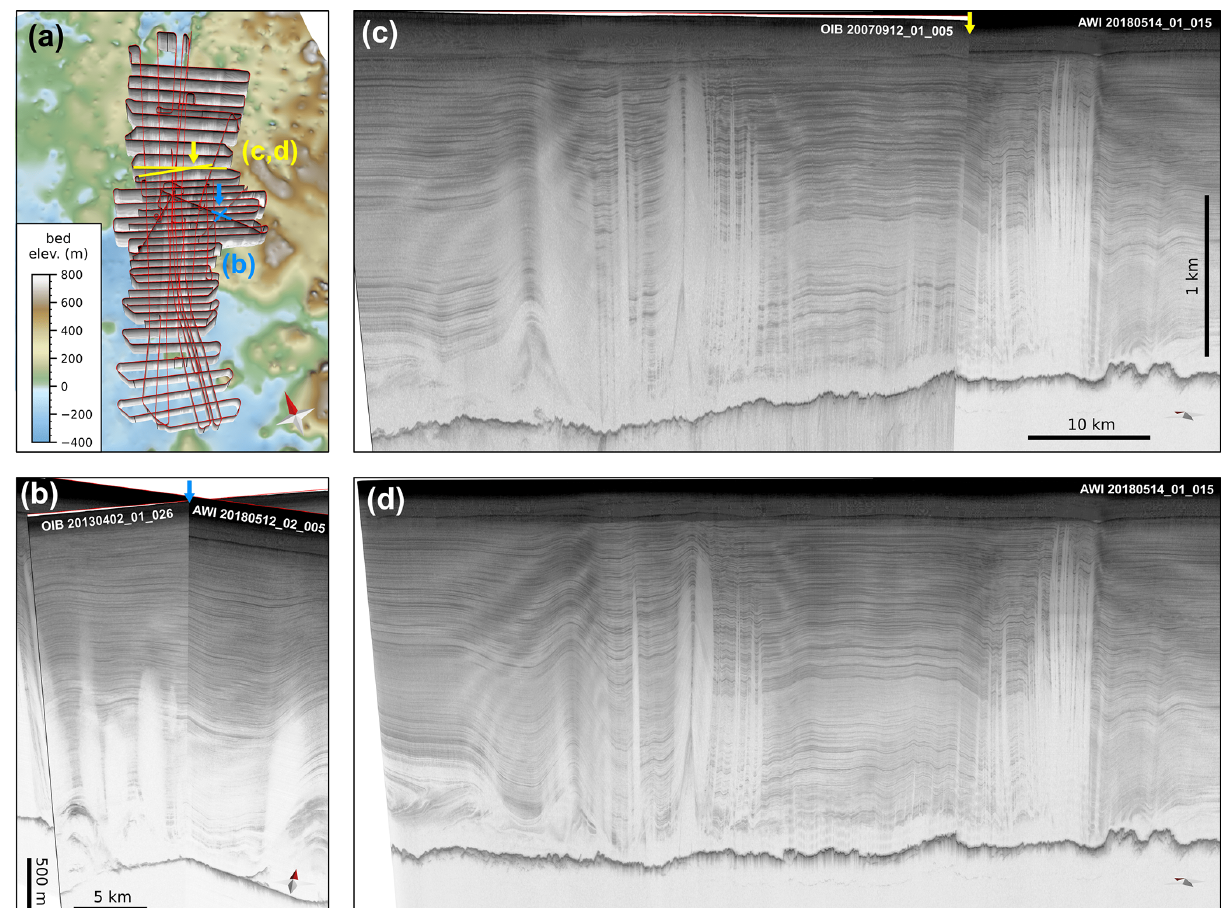
Figure B1. Comparison of selected AWI ultra-wideband (UWB) radargrams with OIB radargrams. (a) Three-dimensional view of the EGRIP-NOR-2018 survey highlighting the location of (b) two intersecting radargrams (OIB profile 20130402_01_026 and AWI profile 20180512_02_003; blue lines in a ) and (c, d) two nearly parallel-oriented profiles showing both shear margins of NEGIS (OIB profile 20070912_01_005 and AWI profile 20180514_01_015; yellow lines in a ). The 2007 OIB radar profile was recorded with the MCRDS (Multi-Channel Radar Depth Sounder) system with a bandwidth of 140–160MHz and the 2013 profile with the MCoRDS 3 (Multi-Channel Coherent Radar Depth Sounder) system with a bandwidth of